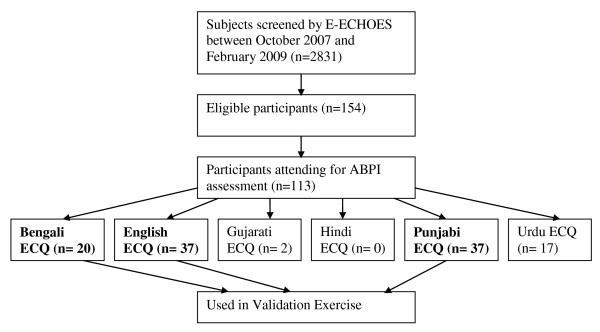
Recruitment of subjects.